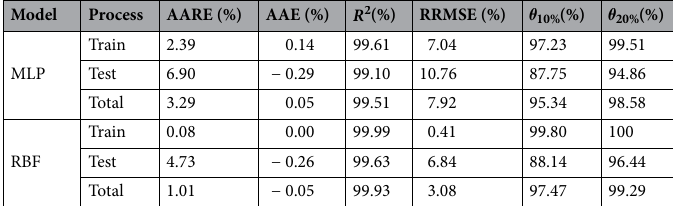
Table 6. Results of the MLP and RBF models for prediction of